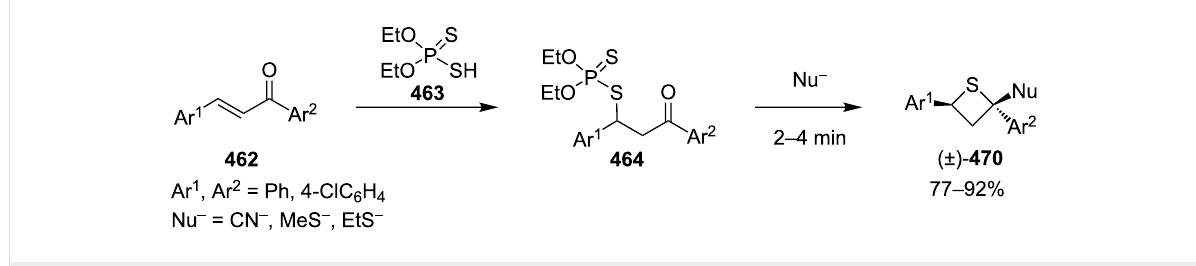
Scheme 106: Phosphorodithioate-mediated synthesis of trisubstituted thietanes (±)- 470 .